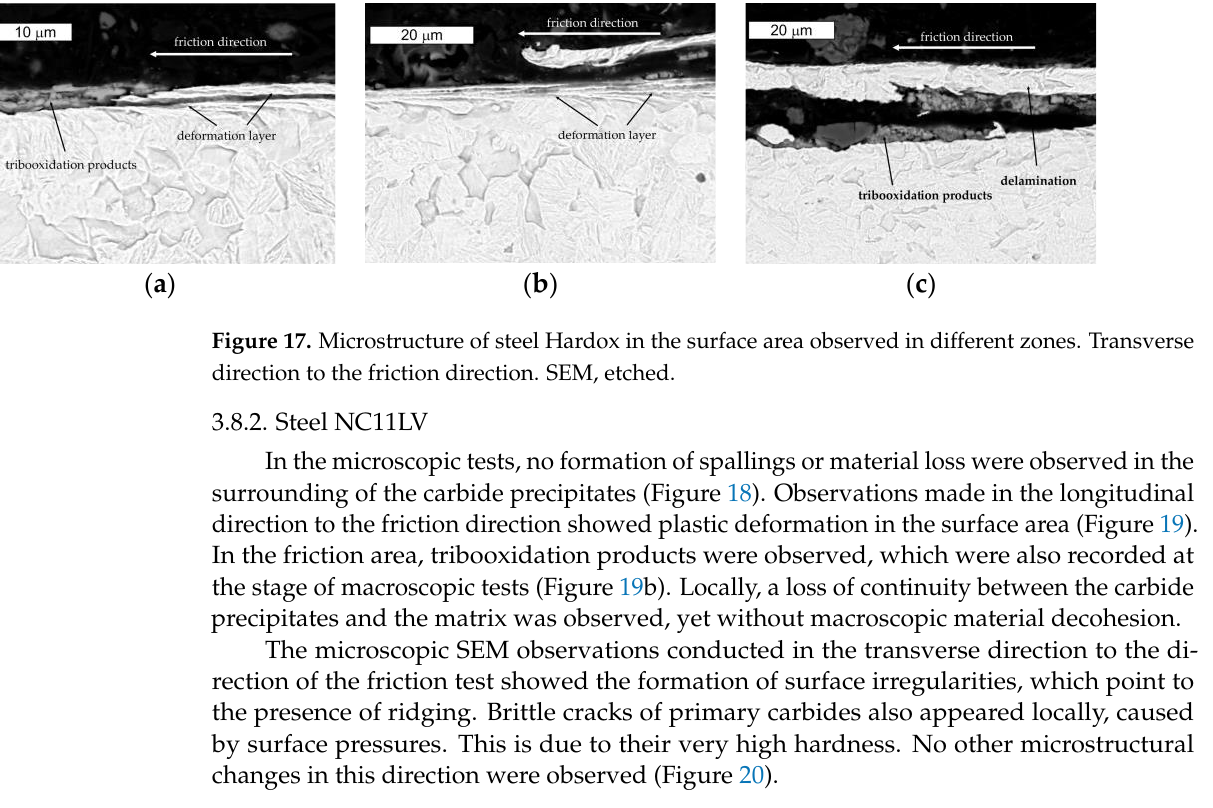
Figure 16. View of ( a ) the microstructure of steel Hardox in the surface area and ( b ) a magnified fragment of the area in Figure 16a in the transverse direction to the direction of the friction track. SEM, etched.